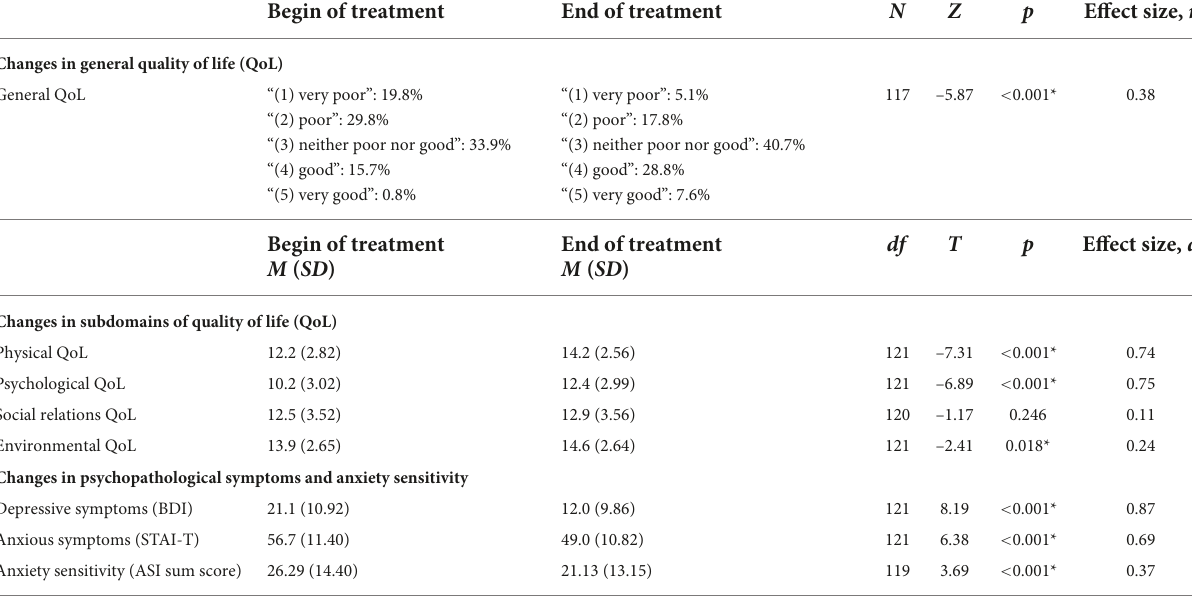
TABLE 4 Changes in quality of life (QoL), psychopathological symptoms, and anxiety sensitivity across treatment descriptive data with relative numbers for general QoL and mean values with standard deviations (SD) for QoL subdomains, anxious/depressive symptoms and anxiety sensitivity at the begin and end of treatment are shown.